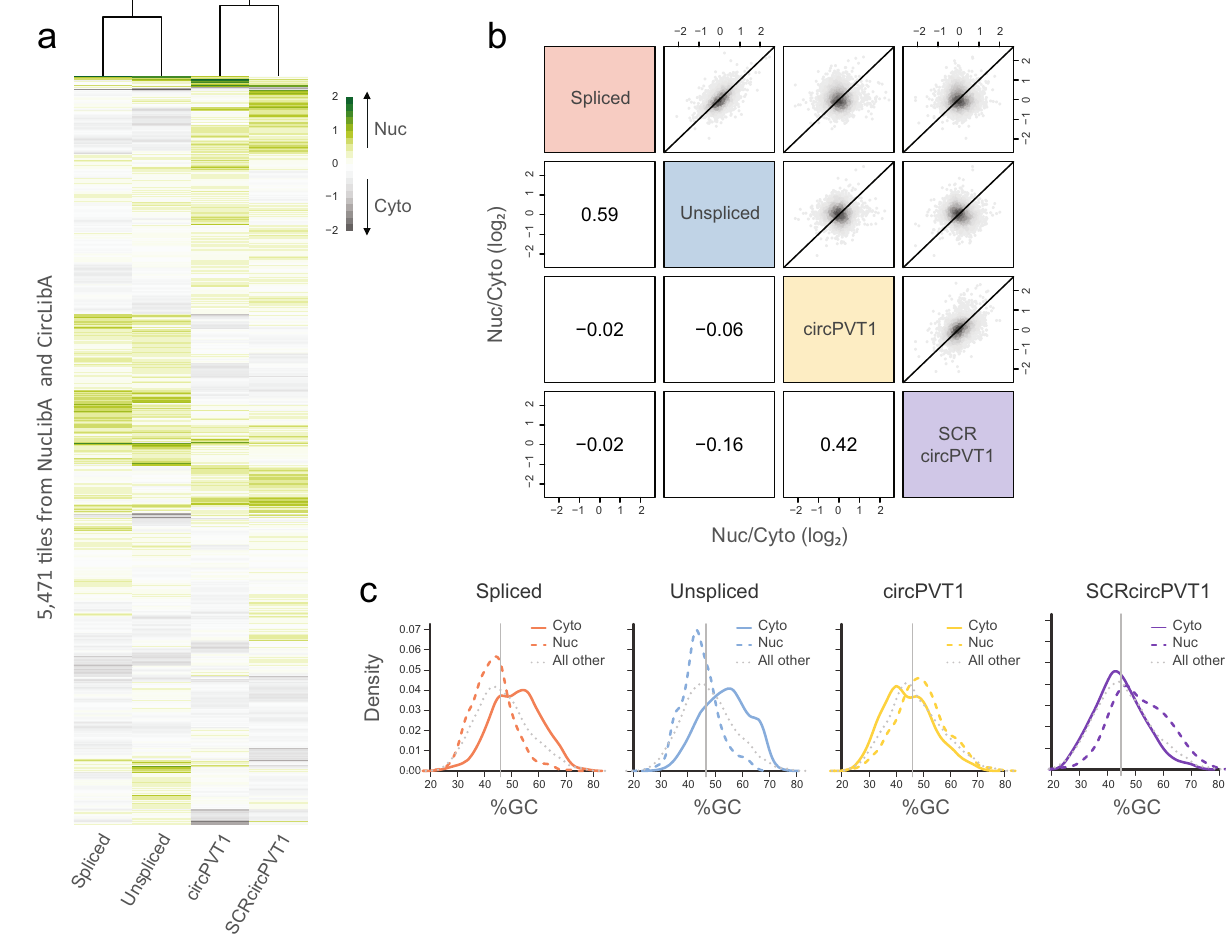
Fig. 2 Parameters of tiles that drive localization to the different cell compartments. a Subcellular localization of all tiles in the spliced, unspliced, circPVT1, and SCRcircPVT1 contexts. Color indicates the median log 2 (Nuc/Cyto) of each tile. Cytoplasmic shift is in gray, nuclear shift is in green. b Correlations between the localization of tiles in spliced, unspliced, circPVT1, and SCRcircPVT1 contexts. c G/C content distributions of tiles enriched in the cytoplasmic fraction (solid line), nuclear fraction (dashed line), or all other tiles (dotted line) in each context. Vertical gray line indicates the median of all tiles in the sample. Source data are provided as a Source data fi